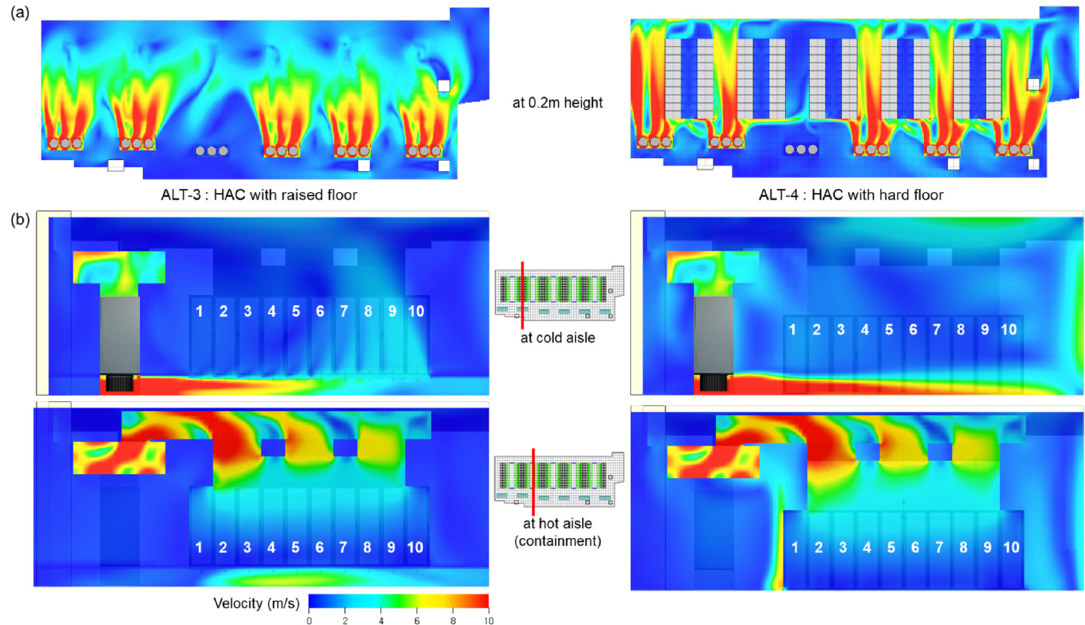
Figure 13. Contours of airflow velocity under cooling fault condition; ( a ) a horizontal section view and ( b ) a vertical section view.